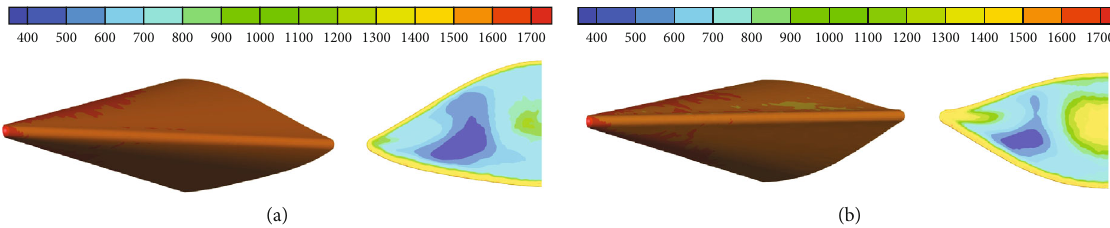
Figure 12: Temperature distribution on the surface: (a) the baseline and (b) the optimum.